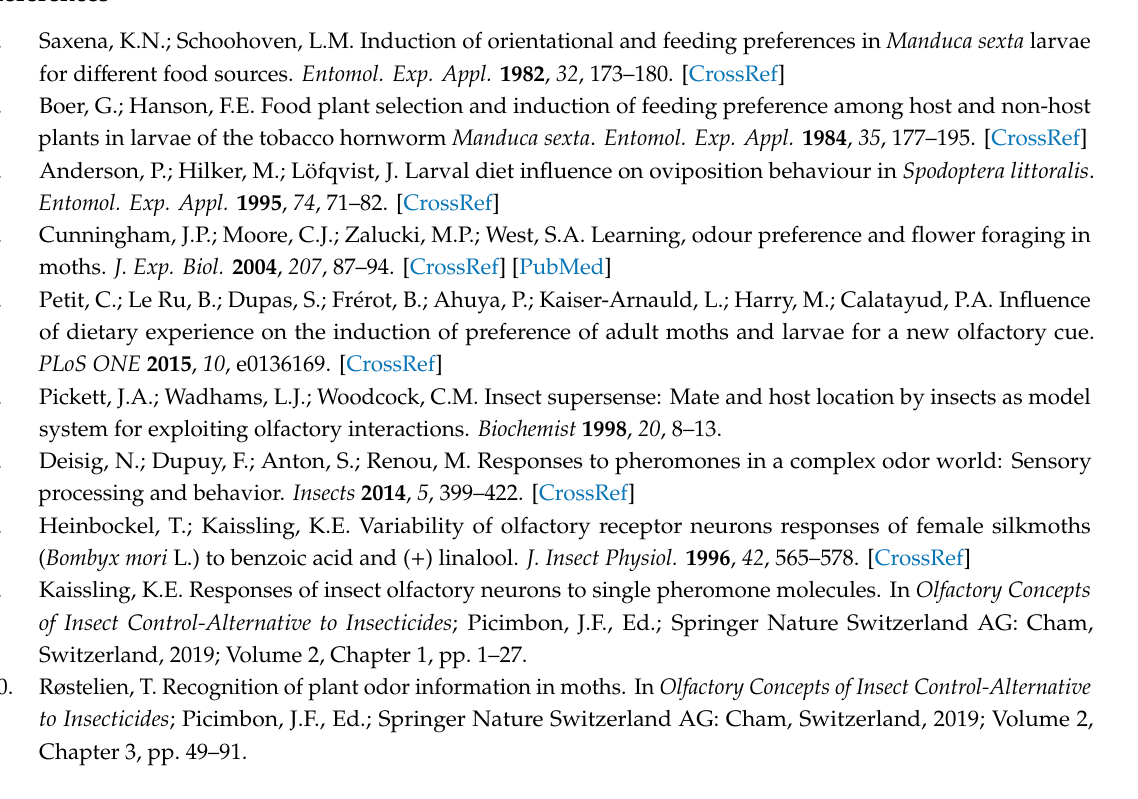
Figure S1. Full-length cDNA sequence encoding Agrotis ipsilon ABPX (AipsABPX). (A) Nucleotide and deduced amino acid sequence of AipsABPX. The N-terminal sequence of the Aipsi2 protein band (Edman degradation) is shown in bold. The underlined regions indicate the annealing positions of specific oligonucleotide primers for one-step RT-PCR. The arrows indicate mutation sites (base changes) on ABPX clones (AAP57464, AY301982, AAP57465, AY301983, AAP57466, AY301984). Non-synonymous mutation sites are shown in red. (B) Identity between hydropathy plots (Kyte and Doolittle, window size = 15 amino acids) of AipsABPX and HvirABPX proteins. The red arrows show the position of mutation sites (in hydrophilic regions). Figure S2. Alignment of amino acid sequences from AipsABPX with other moth ABPXs and related proteins in the insect OBP family. Agrotis ipsilon AipsABPX (AAP57464, AY301982, AAP57465, AY301983, AAP57466, AY301984), Sesamia inferens SinfABPX (AGS36754), Heliothis virescens HvirABPX (CAA05508), Spodoptera exigua SexiABPX (AGP03461), Bombyx mori BmorABPX (CAA64446) , Antheraea pernyi AperABPX (CAA05509), Manduca sexta MsexABPX (AAF16697), Tribolium castaneum TcasOBP6 (EFA04594), Rhynchophorus palmarus RpalOBP4 (AAD31883, AAO64978), Popillia japonica PjapOBP1 (AAC63436), Anomala osakana AosaOBP1 (AAC63437), Phyllopertha diversa PdivOBP1 (BAA88061), Lygus lineolaris LAP (AAC43033), Locust migratoria OBP1 (4PT1-A), Drosophila melanogaster DmelPBP-RP3 and DmelPBP-RP6 (AAA21356, NP52424, NP524039), Anopheles gambiae AgamOBP1 (2ERB-A) and Agam17561 (XP321724), Apis mellifera ASP1 (AAD51944), Rhynchophorus palmarus RpalOBP2 (cid:48) (AAD31883, AAO64978), Anopheles gambiae AgamOBP16 (AAO12082), Zootermopsis nevadensis OBP1 (AAN15921, KDR09910) and Drosophila melanogaster DmelPBP-RP1 (AAA21356, NP52424, NP524039). The six cysteine residues characteristic of the OBP family are shown in pink. The asterisks show the position of conserved cysteines. Highly conserved amino acids are indicated in blue. Residues in common between moth ABPX and counterparts in other insect species are boxed. The boxes in bold show highly conserved amino acid residues in moth ABPXs. The amino acid profile characteristic of noctuid ABPXs is shown in yellow. The N-terminal sequence of the Aipsi2 protein band (Edman degradation) is shown in